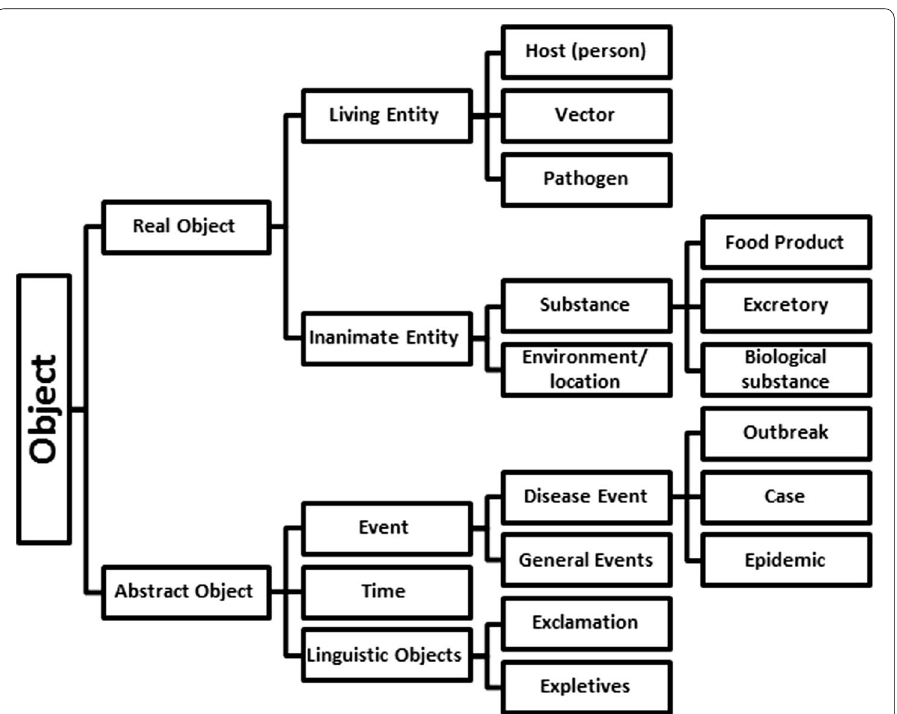
Fig. 2 Partial object hierarchy for disease communication